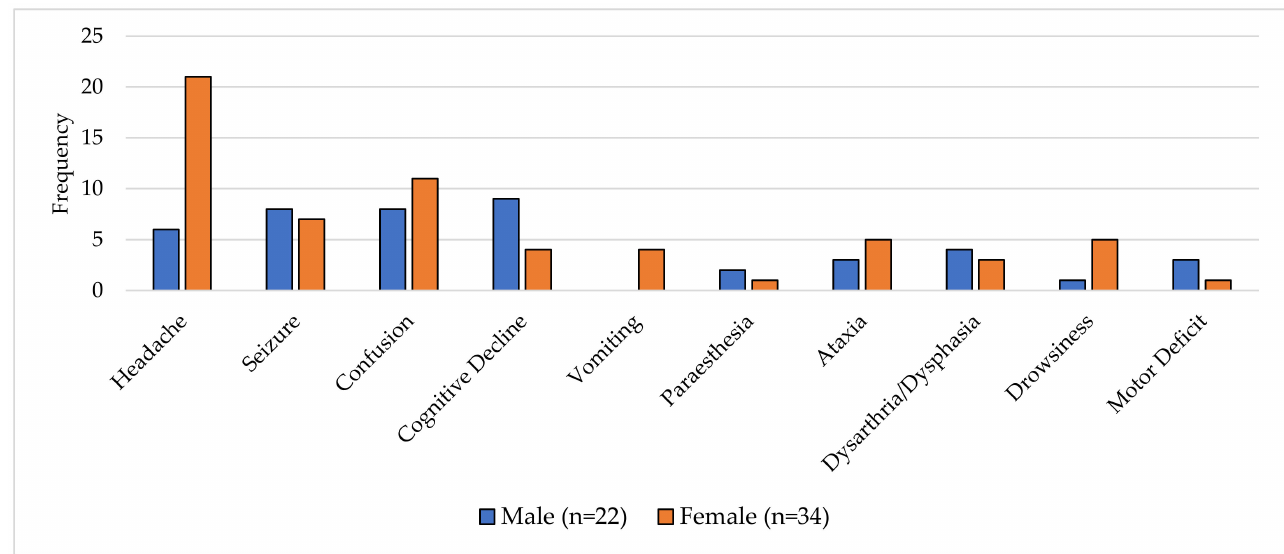
Figure 1. A graph of presenting symptoms of CD8E by sex ( n =